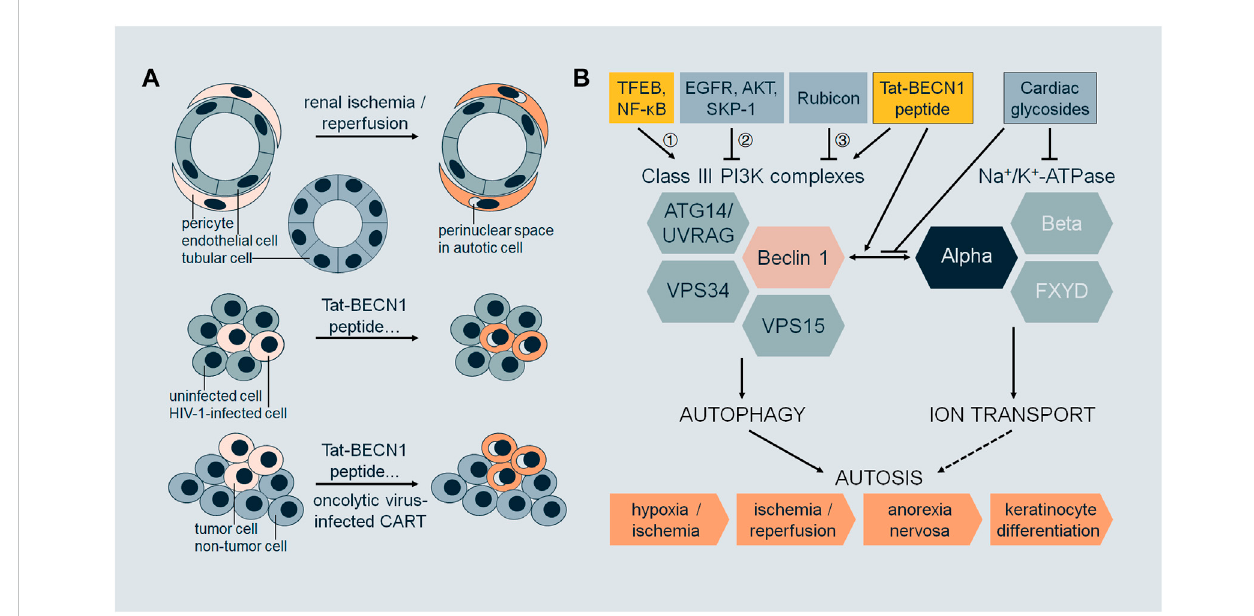
FIGURE 1 (A) Selectivity of autosis. During renal ischemia/reperfusion, pericytes undergo autosis (with morphological features such as focal swelling of the perinuclear space), but not tubular cells or endothelial cells. Upon treatment with Tat-BECN1 peptide or other autosis inducers, HIV-1-infected cells (macrophagesorCD4 + Tcells)undergo autosis,butnotuninfectedcells.Upontreatment withTat-BECN1peptideorotherautosisinducers,oroncolytic virus-infected CAR-T cells, tumor cells undergo autosis, but not non-tumor cells. (B) Regulation of autosis. Class III PI3K complexes and Na + /K + - ATPasearetwomajor mediatorsofautosis,whichinteractthroughBeclin1andalphasubunits.Pharmacologically,theinteractionisenhancedbyautosis inducer Tat-BECN1 peptide and blocked by autosis inhibitor cardiac glycosides. Regulatory proteins of autosis act on Class III PI3K complexes by 1) transcriptional regulation, 2) post-translational modi fi cations, and 3) protein – protein interactions. Autosis occurs in vivo , in the brain during cerebral hypoxia/ischemia, in the kidney during renal ischemia/reperfusion, in the heart during cardiac ischemia/reperfusion, in the liver during anorexia nervosa, and in the skin during terminal differentiation of keratinocyte lineage